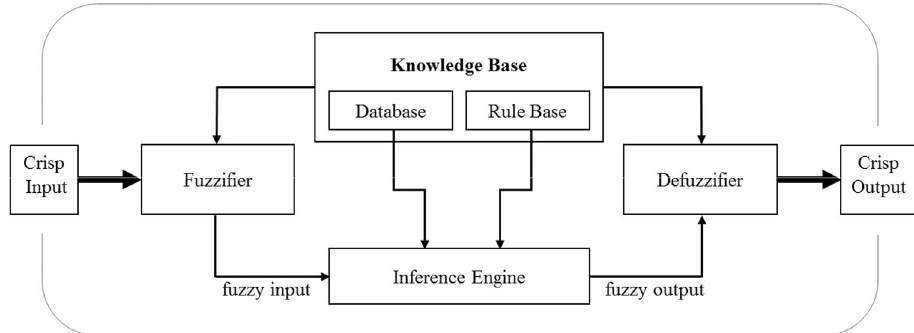
Fig. 2 Basic structure of